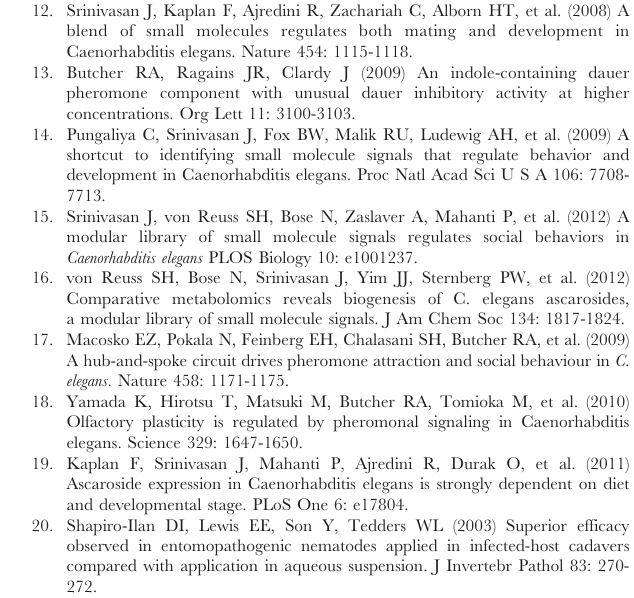
Figure S4 Ascr # 9 can replace the function of ascr # 2 in the C. elegans dispersal blend. Representative pictures are presented. Negative control using 0.25% E. coli HB101 (3 experiments), ascr # 9 substitution in the C. elegans dispersal blend (6 experiments), and positive controls: the synthetic blend dispersal blend (7 experiments) and positive control dauer liquid culture (3 experiments). Figure S5 Dispersal blend of the phylogenetically re- lated nematodes species. (A) Phylogenetic tree for entomo- pathogenic nematodes, plant parasitic nematodes and C. elegans . The figure is adapted from C. elegans and the biology of nematodes [7]. Red color indicates the example of genera. (B) Host insect cadaver of Steinernema spp. and Heterorhabditis spp. For each species, four insect ( G. mellonella ) cadavers infected with both Steinernema spp. or Heterorhabditis spp. were analyzed by LC-MS for ascr # 9 and ascr # 11